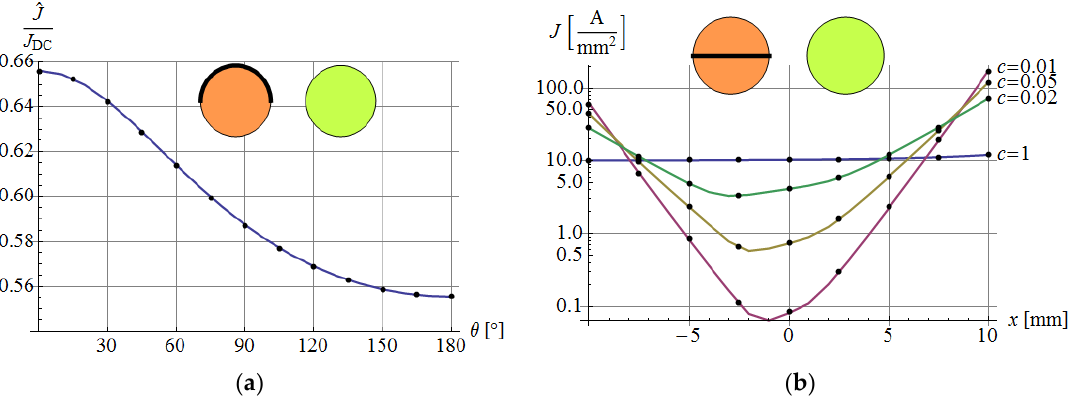
Figure 7. Current density values (lines) in twin line compared with reference solution (dots) from work [2], problem 2: ( a ) current density related to DC current density at the same voltage drop on the line for aluminum wires ( R = 10 mm, d = 40 mm, f = 60 Hz, R / δ = 0.935); ( b ) absolute values of current density at voltage drop equal to 1 V / m for several values of c = σ Al / σ